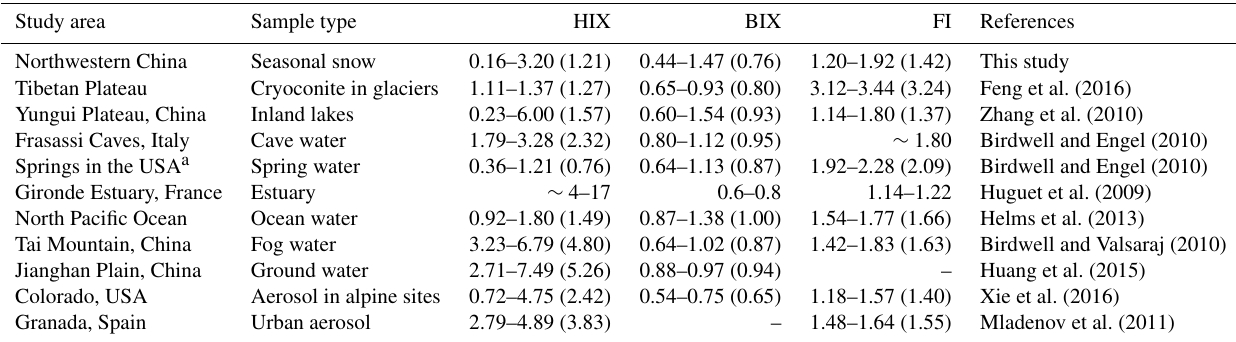
Figure 7. Variations of HIX (red), BIX (blue), and FI (green) among regions. The meaning of each part of the box is same as that in Fig. 5. Table 3. The fluorescence-derived indices in this study and comparison with those of natural water bodies and water extractions of aerosols reported by other studies. Note that average values are shown in parentheses.